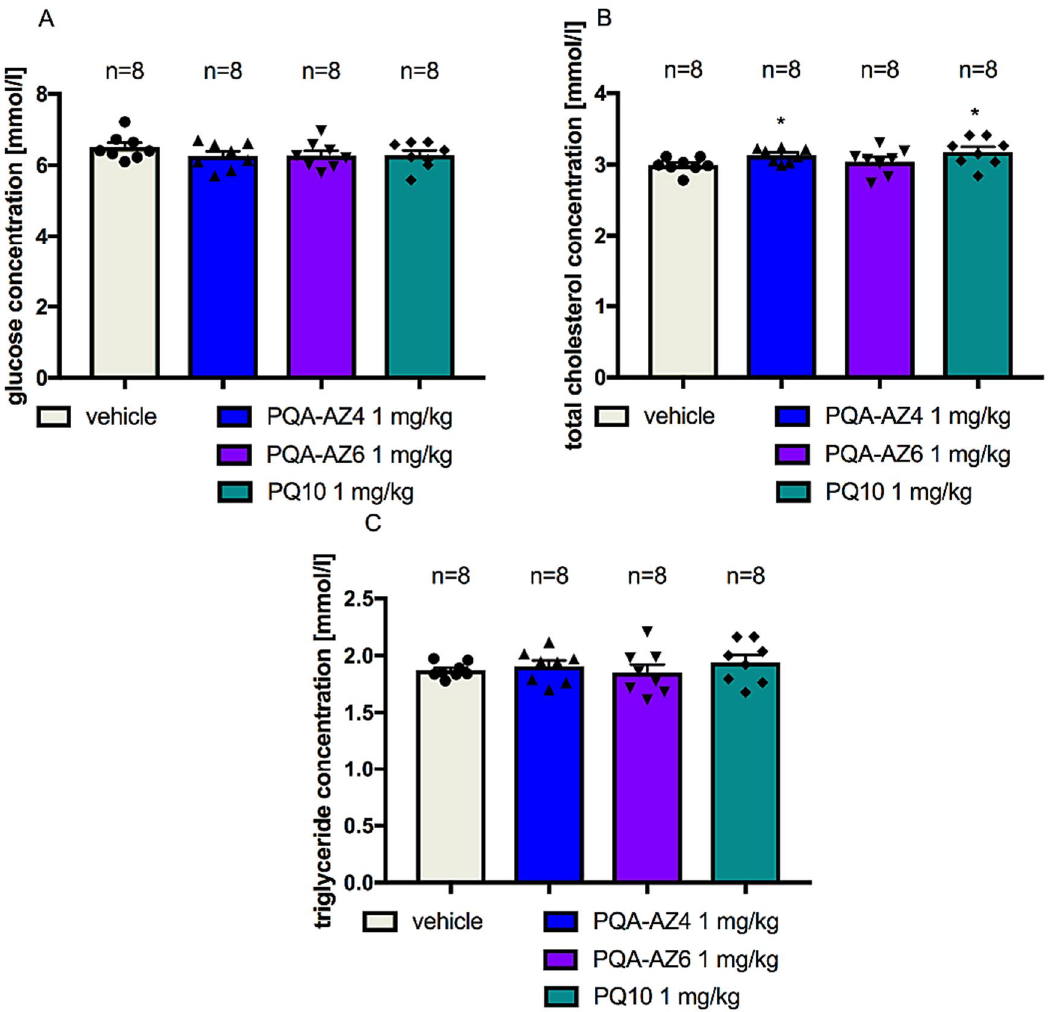
Figure 6. Effects of repeated administration of PQA-AZ4, PQA-AZ6, and PQ-10 on glucose ( A ), triglyceride ( C ), and cholesterol concentration ( B ) in rat serum. PQA-AZ4, PQA-AZ6, and PQ-10 were administered i.p. once daily for 21 consecutive days. Data represent the mean ± SEM, n = 8 rats per group; statistical analysis was performed using the Student’s t -test, * p < 0.05 vs. respective vehicle-treated group.